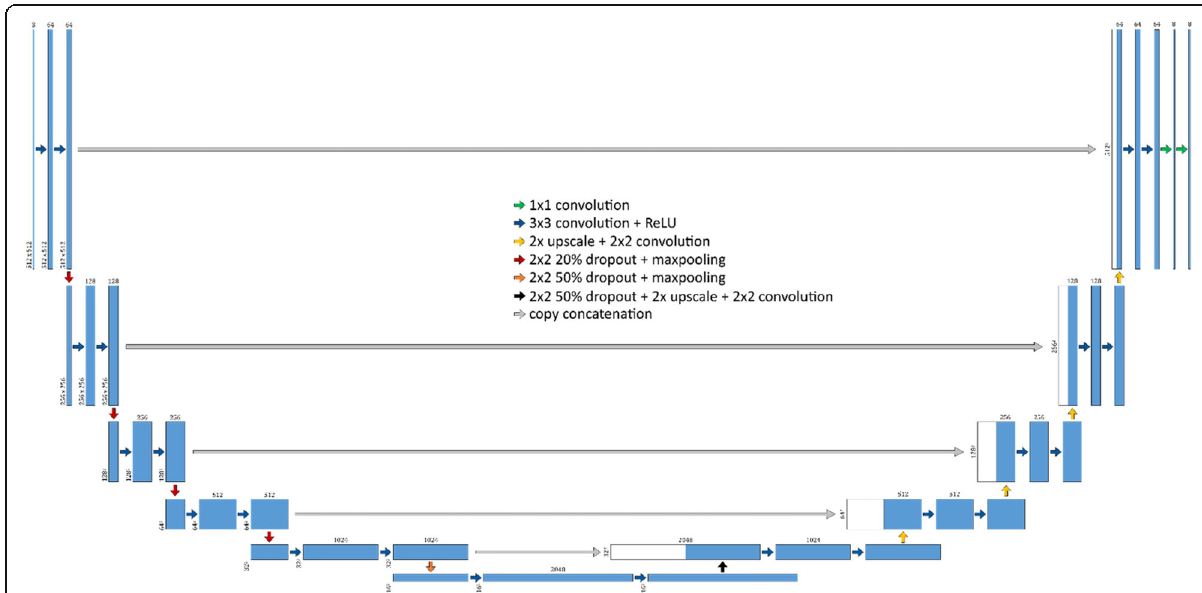
Fig. 2 Modified U-Net architecture with 12 layers. Numbers on the top of blocks represent the number of feature maps, while numbers on the slide of blocks represent the feature map